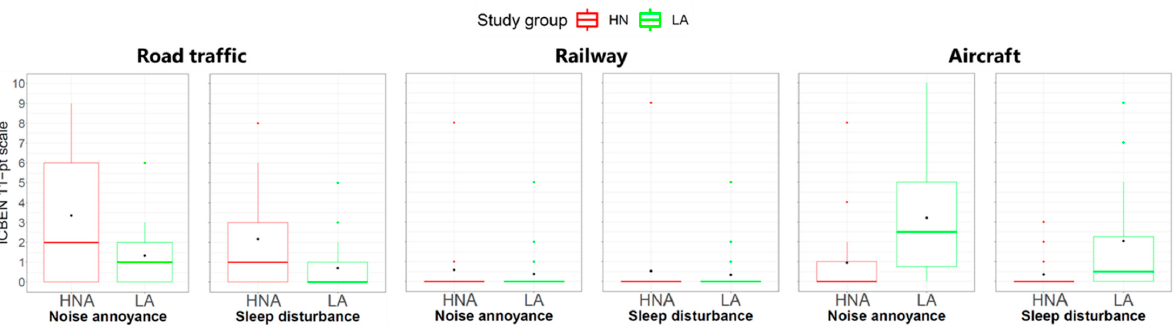
Figure 9. Boxplots of noise annoyance and self-reported sleep disturbance for road traffic ( left ), railway ( center ) and aircraft noise ( right ) for the two study groups High noise exposure at home with No access to GSs (HNA, in red) Low noise exposure at home with access to GSs (LA, in green). While differences between the HNA and LA groups were non-significant, there were significant differences between highly annoyed and non-highly annoyed persons regarding their exposure to L day and VEG-H. In contrast, no significant differences were observed in the ability to cope with stress and stress in private life (Table 5). Table 5. Differences in stress and exposure characteristics in a 50 m buffer around home between the non-highly (Non-HAnn) and highly annoyed persons (HAnn) by road traffic noise, and p - values. Ability to cope with stress